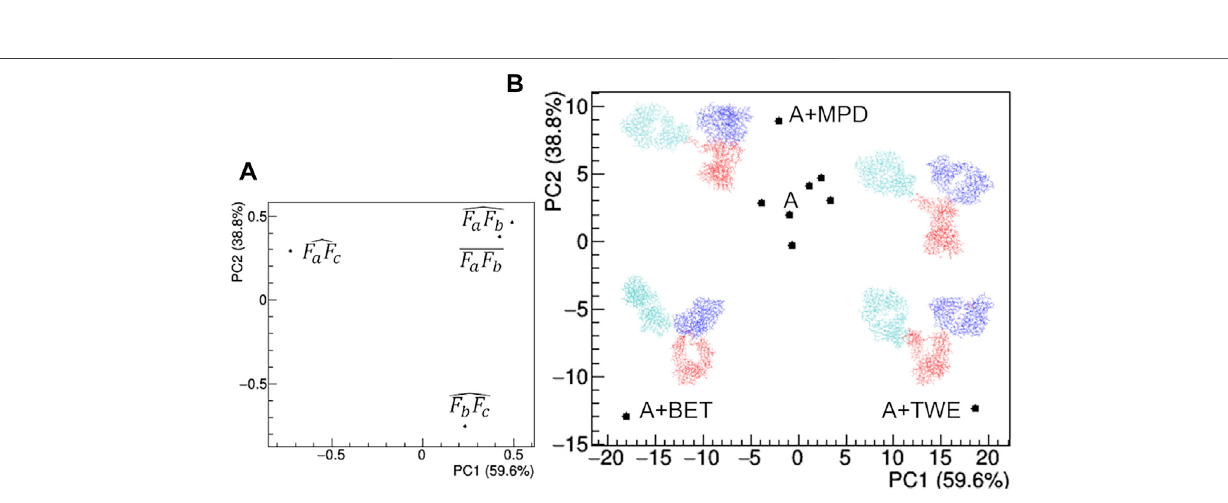
Frontiers in Molecular Biosciences |